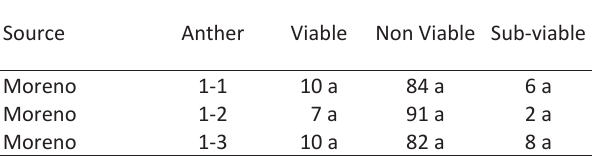
Values are expressed on percentage. Values with different letters between the same column are significant different. Tukey